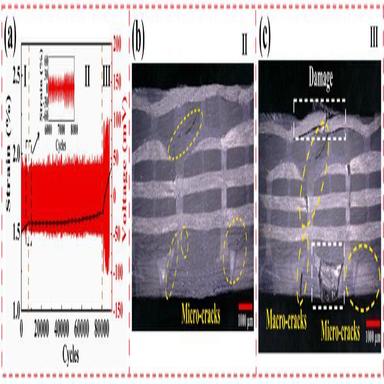
(a) Response relationship between electrical signal and strain during fatigue testing. (b) The microcrack failure morphology of the second stage 3DOPC and (c) the final failure morphology of the third stage 3DOPC during the fatigue test.